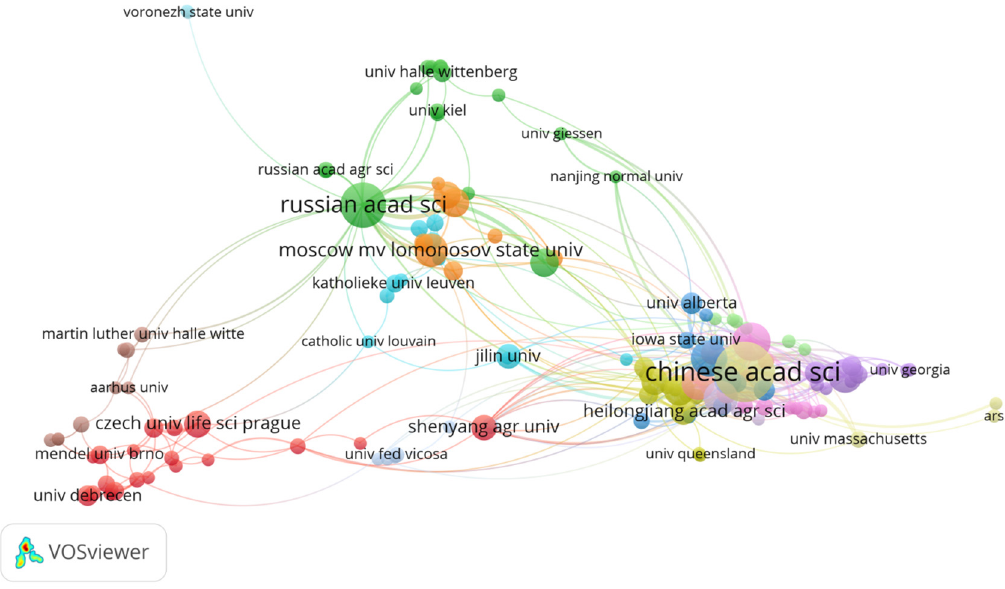
Figure 3. Clustering mapping of institution collaboration networks for BSC domain publications. Table 2. Information on the top 20 institutions in terms of number of publications.